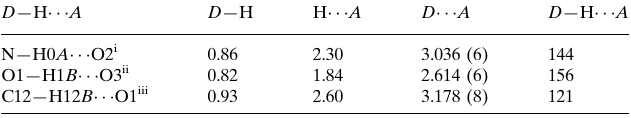
Hydrogen-bond geometry (A˚ , (cid:2)